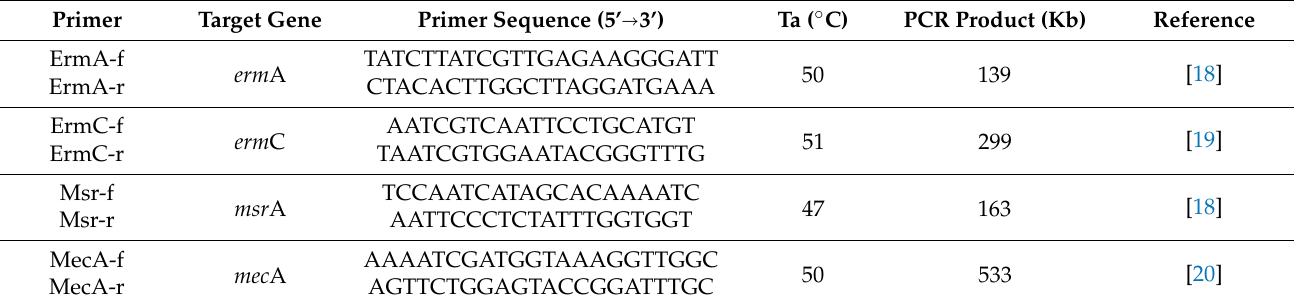
Table 2. The primer sequences used in this study and the expected PCR product sizes.